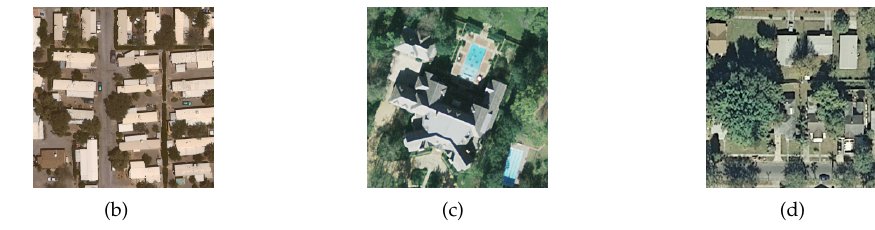
Figure 7. The misclassified images from the dense residential and the sparse residential classes.